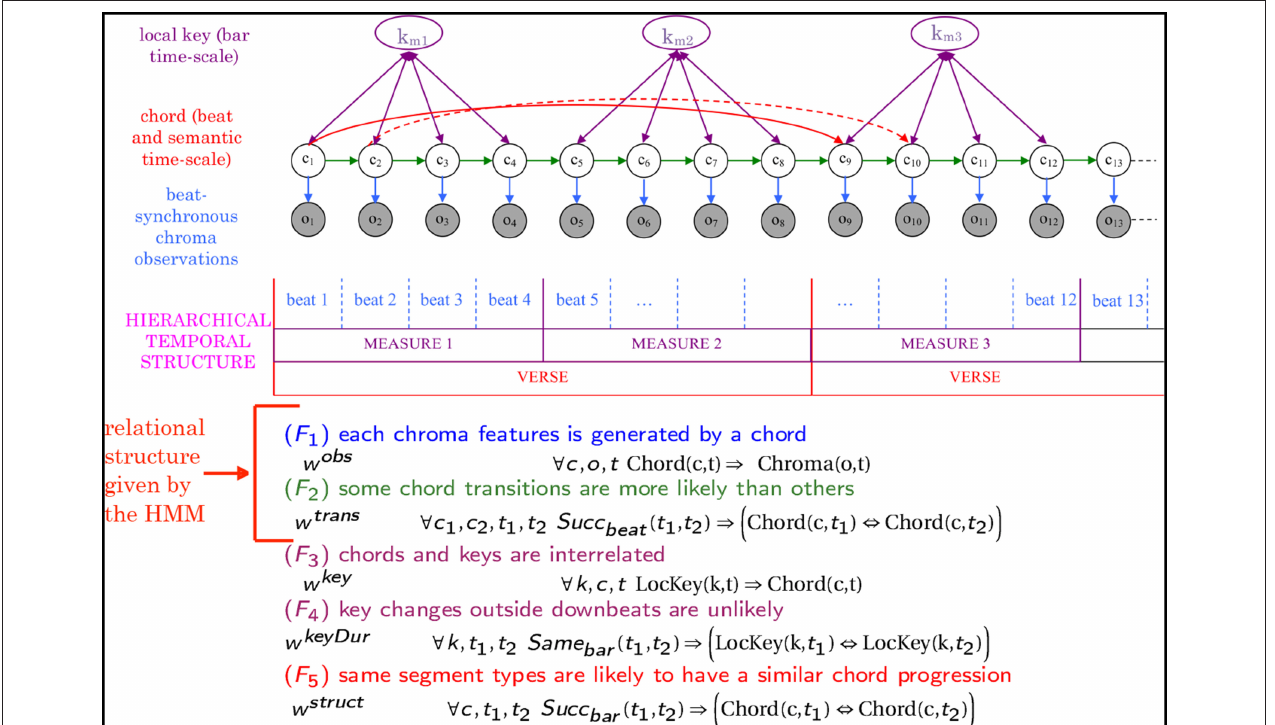
FIGURE 11 | Markov logic network for tonal harmony analysis of music. The model combines harmony-related information (chords, local key, and semantic structure) that interact at various time scales (analysis frame, phrase and global structure) in a single unified formalism. Relational structure is expressed in terms of logical formulas that are used as a template to build a probabilistic graphical model. The first two formulas compactly encode the relational structure that can be modeled with a